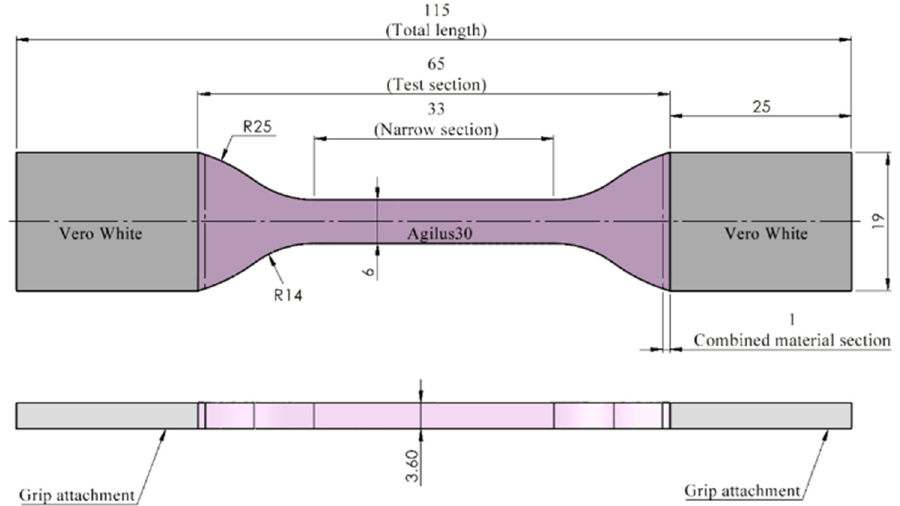
Figure 1. The dog-bone specimen Type IV shape and dimensions according to ASTM Standard D638. Total length 115 mm; test section 65 mm; narrow section 33 mm; grips attachments 26 mm × 19 mm; combined material section 1 mm; width; 6 mm; thickness 3.6 mm.